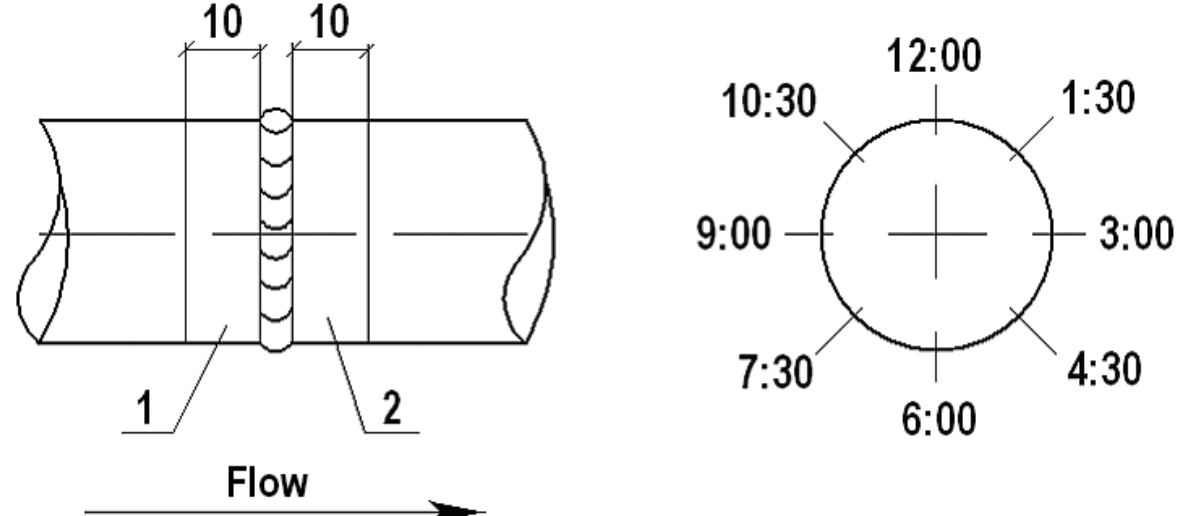
Figure 1. Layout of measurements of wall thicknesses of ZAWJ in eight points along the circumference: 1 – inlet zone; 2 – outlet